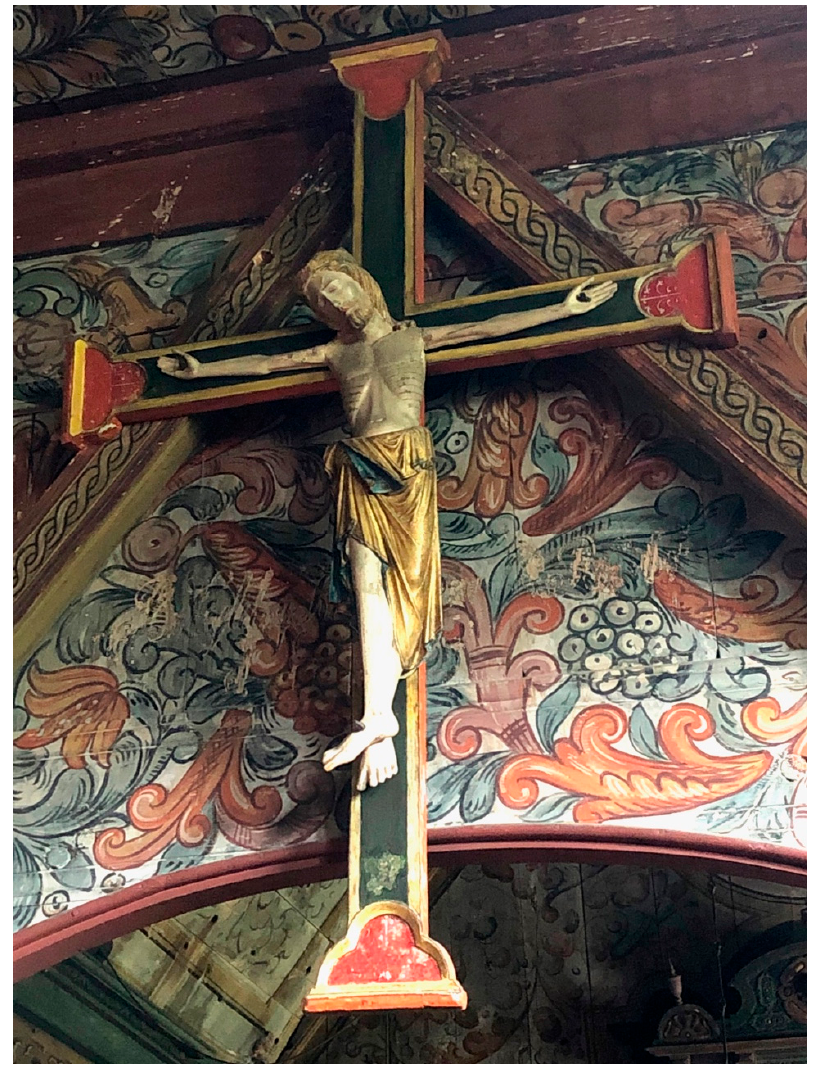
Figure 8. The Røldal Crucifix. 1240–1255. Cross H 157cm. Figure H 89 cm. Photo: Kaja M. H. Hagen.